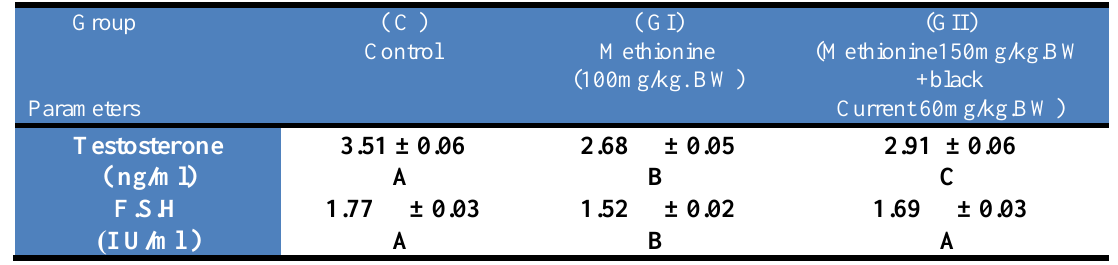
Values are expressed as mean ± SE; n= 6 / group. Different capital letters denote between groups differences, P< 0.05 Vs. control. Table (2): Effect of alcoholic extract of Black Current and methionine overload on diameter and thickness of seminiferous tubules in adult male rats.